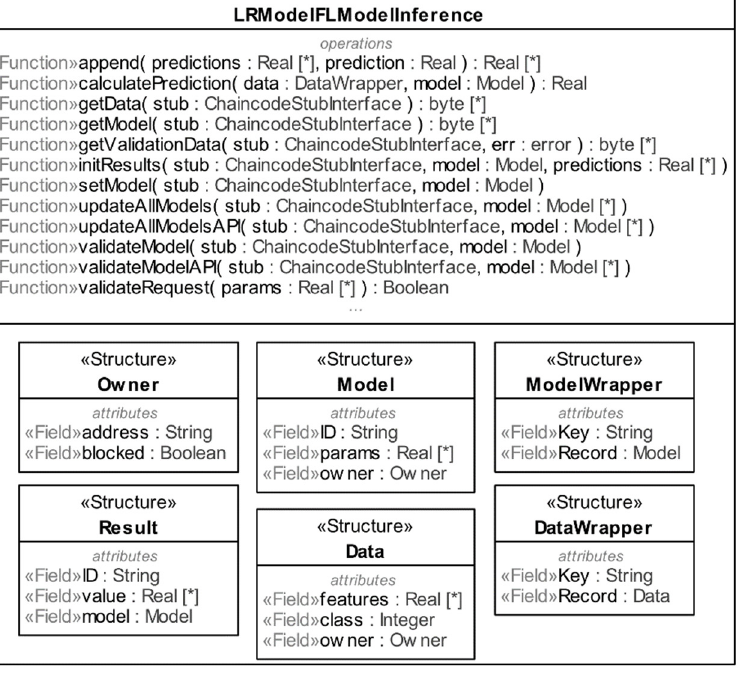
Figure 3. Smart contract structure: UML class diagram representing the main structures and functions of the class LRModelFLModelInference.